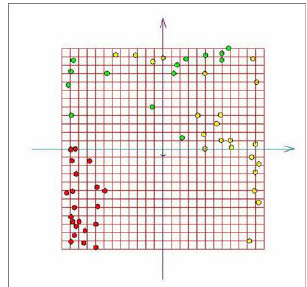
Figure 7. Extension of elastic map for classes car, con,